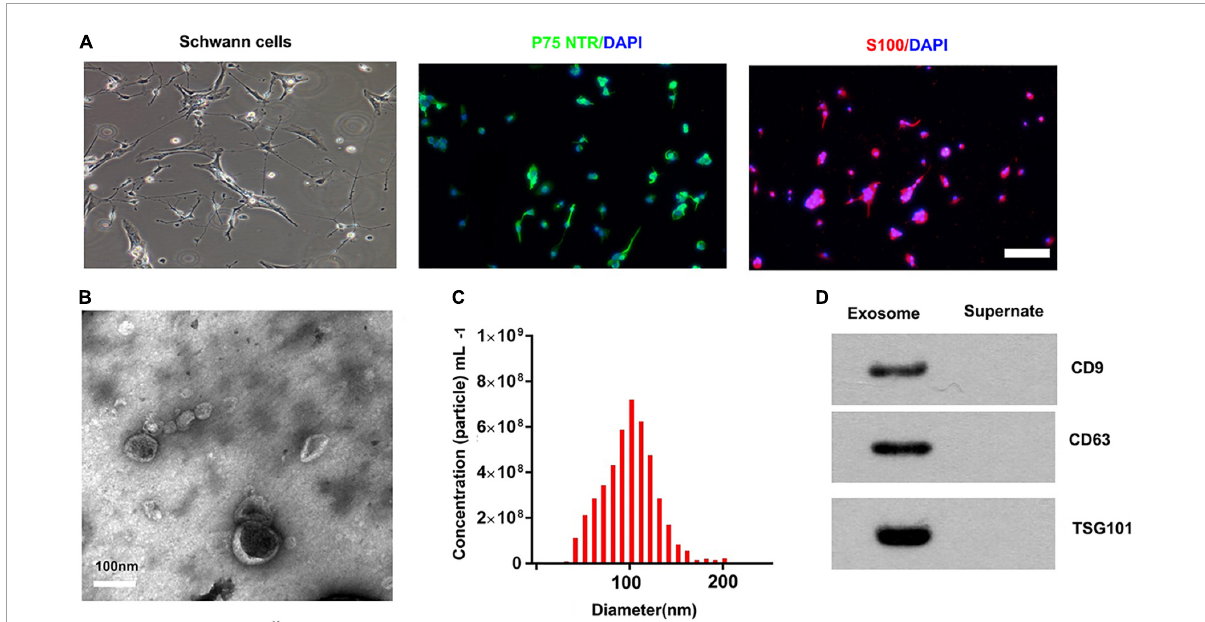
FIGURE1 Characterization of SCs and derived exosomes. (A) Phase contrast image of the Schwann Cells (SCs). Immunofluorescence stain of the surfer markers-P75 NTR (green) and S100 (red) of SCs. Scale bar = 100 µ m. (B) The Transmission electron micrograph of exosomes, Scale bar = 100 nm. (C) The nanoparticle tracking analysis of the exosomes. (D) The specific surface markers of exosomes, such as CD9, CD63, and TSG101 were then confirmed by Western